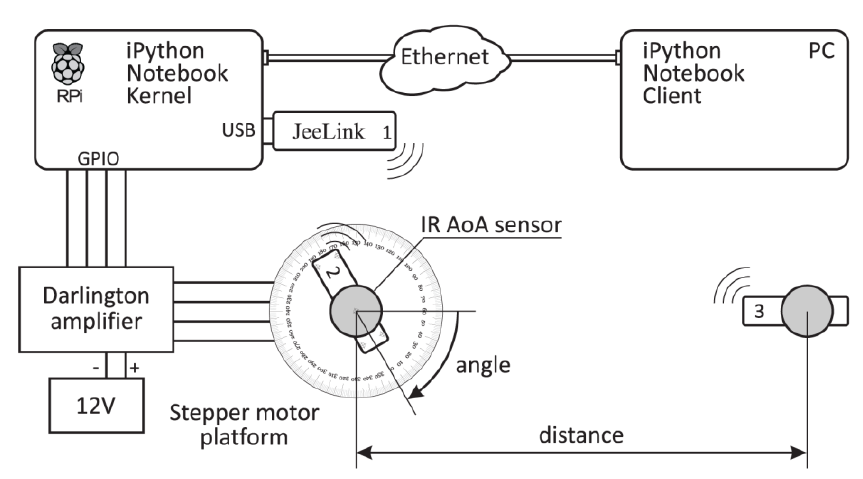
Figure 3. AoA sensor calibration system [36].